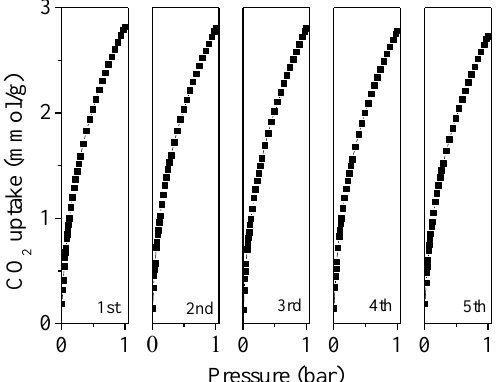
Figure 8. Cyclic study of CO 2 adsorption for UFK-600-0.2 at 25 °C and 1